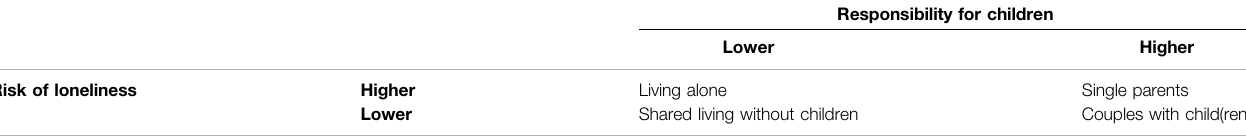
TABLE 1 | Types of living